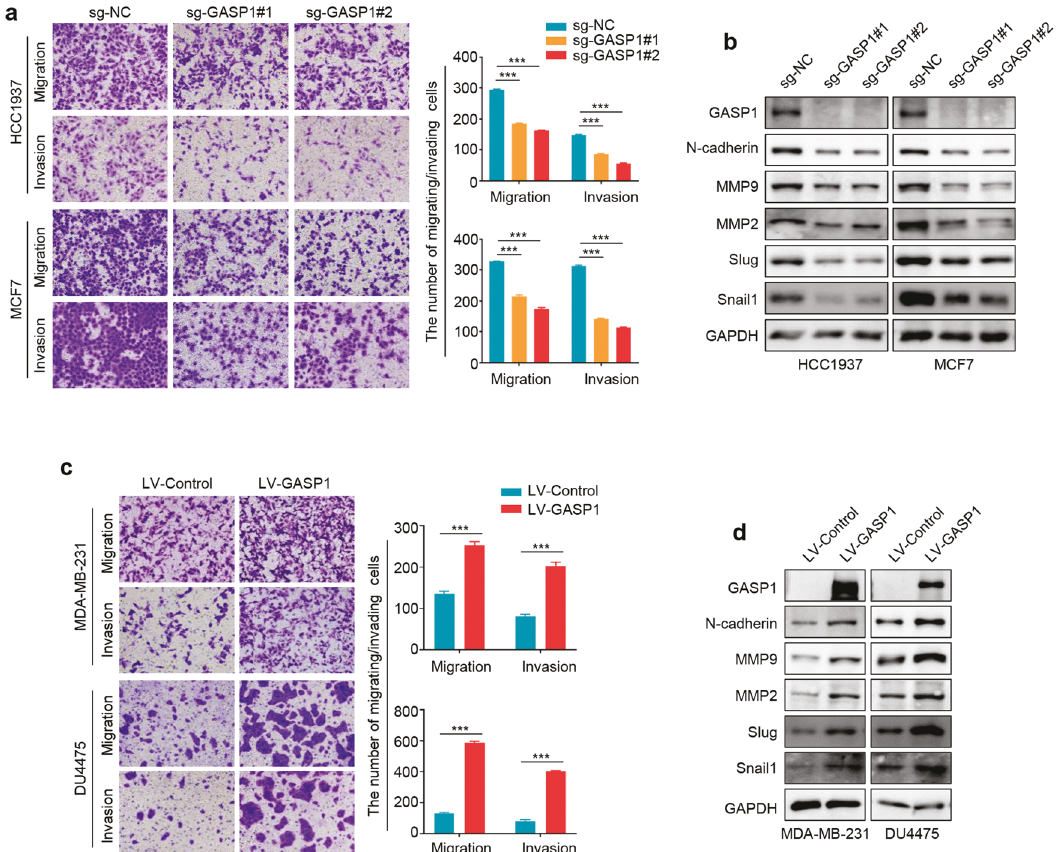
Fig. 3 The promoting effect of GASP1 on the invasiveness of breast cancer cells. a GASP1 knockout suppressed the migration and invasion potential of HCC1937 and MCF7 cells. The representative pictures of migrated/invaded cells were shown in the left panels, and statistical data of cell numbers was shown in the right panels. b GASP1 knockout down-regulated the expression of several metastasis-related genes in HCC1937 and MCF7 cells compared with the control, including N-cadherin, MMP9, MMP2, Slug, and snail. c GASP1 overexpression enhanced the migration and invasion potential of MDA-MB-231 and DU4475 cells. The representative pictures were shown in the left panels and migrated/invaded cell quanti fi cation was shown in the right panels. d Ectopic expression of GASP1 in MDA-MB-231 and DU4475 cells up- regulated the expression of N-cadherin, MMP9, MMP2, Slug, and snail. Data were presented as mean ± SD. *** P <